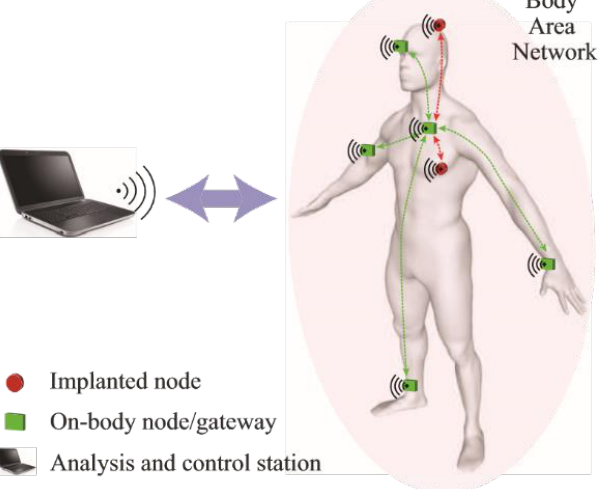
Figure 1. Illustration of wireless body-area network.